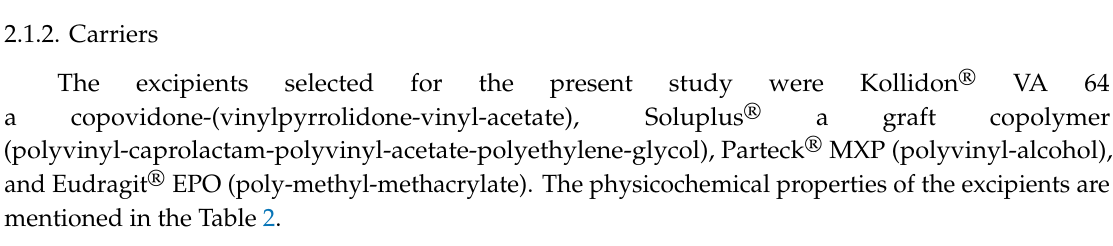
Table 2. Physicochemical properties of polymers used in amorphous solid dispersions